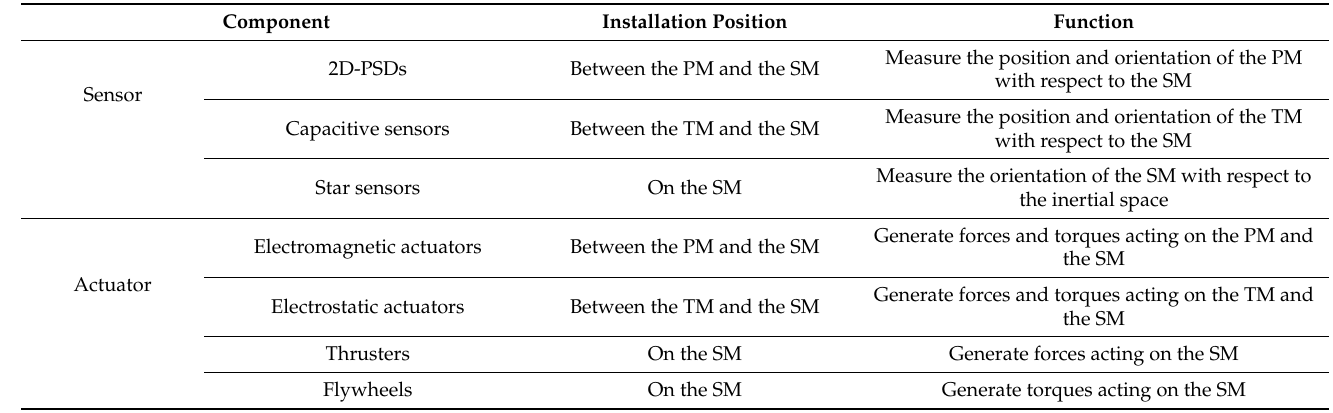
Table 1. Sensors and actuators of the improved DFP